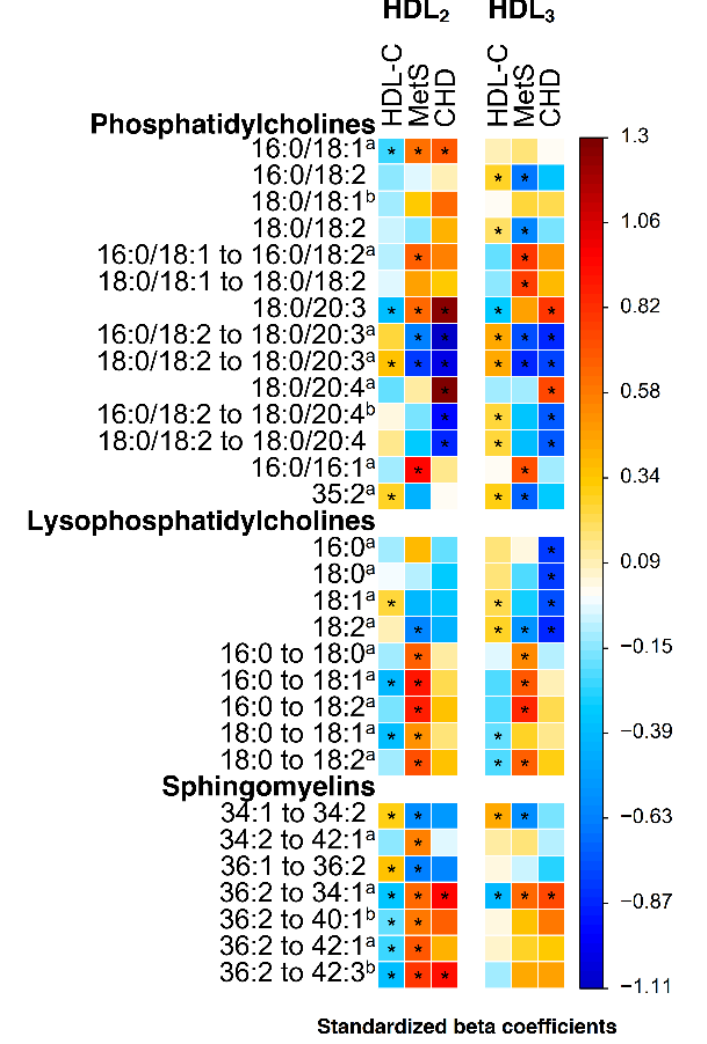
Figure 1. Associations of lipids and lipid ratios with metabolic syndrome (MetS), plasma HDL cholesterol level (HDL-C) or with premature coronary heart disease (CHD). Standardized beta coeffi- cients of statistical models which estimated separately the effect of metabolic syndrome, premature CHD or HDL-C level on each of the lipid parameters are displayed. The models of metabolic syn- drome and HDL-C were statistically adjusted for sex and age (premature CHD was investigated in manually age-adjusted groups of only male subjects, see Section 4.1 for details). Generalized esti- mating equation was applied in the modeling (see Section 4.2.7. for details). For numeric and further data, please see Table S1. * Statistically significant association, Benjamini–Hochberg corrected false detection rate in multiple comparisons < 5% (see Section 4.2.7. for details); a log-transformed, b square root-transformed.